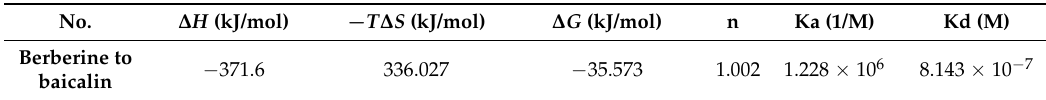
Table 4. Binding thermodynamics of baicalin and berberine.